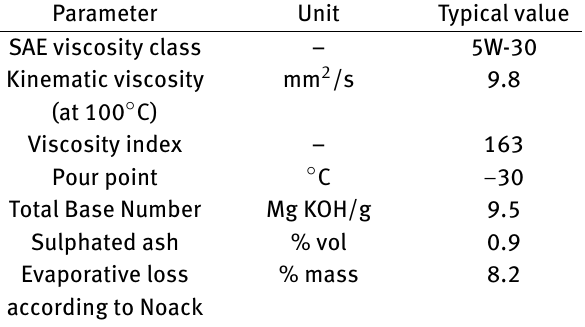
Table 3: Properties of oil